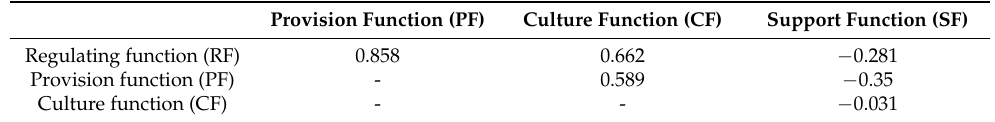
Table 3. Spearman rank correlation coefficient of landscape